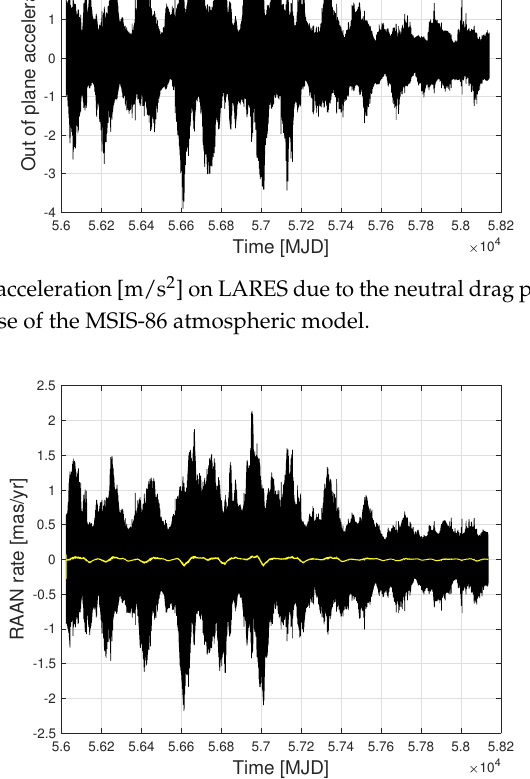
Figure 7. Neutral drag effects [mas/yr] on the precession of LARES right ascension of the ascending node (RAAN) computed by means of Equation